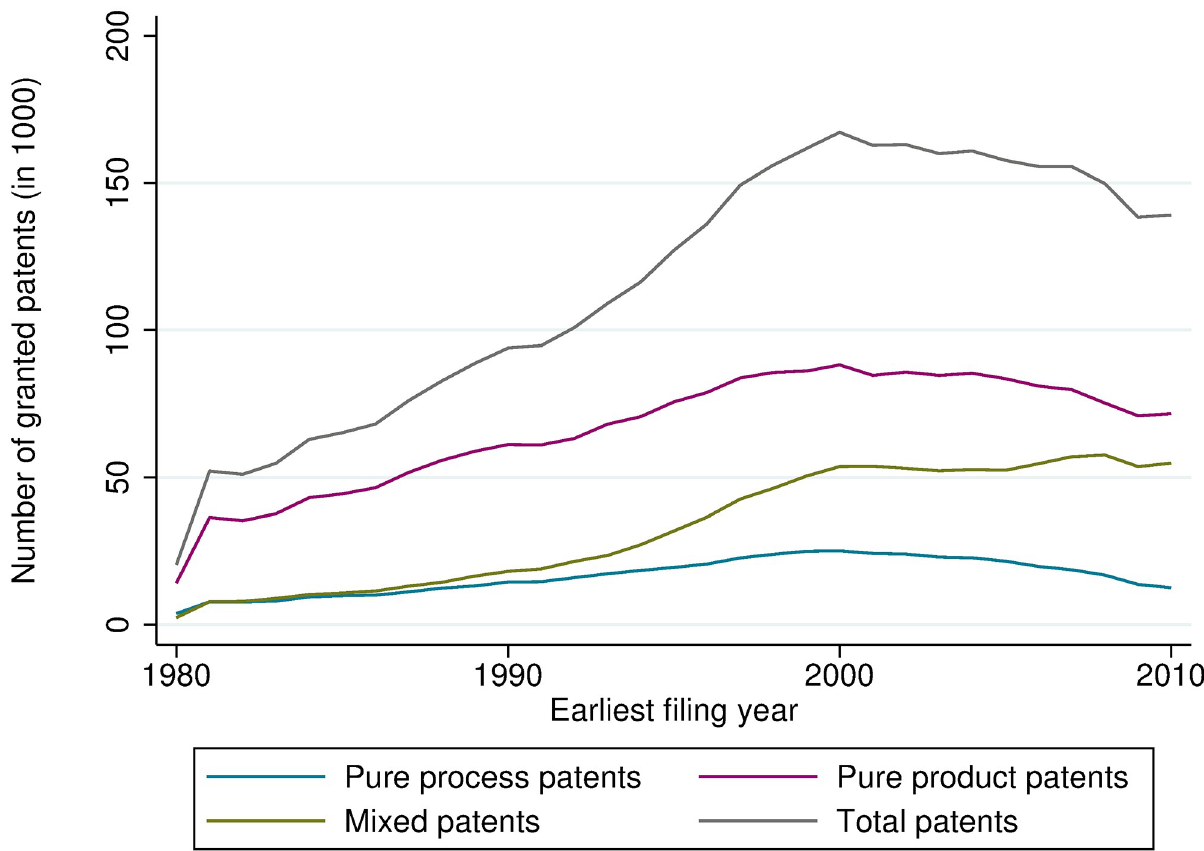
Fig 4. Count of product, process-use, and mixed patents, USPTO, based on independent claims.